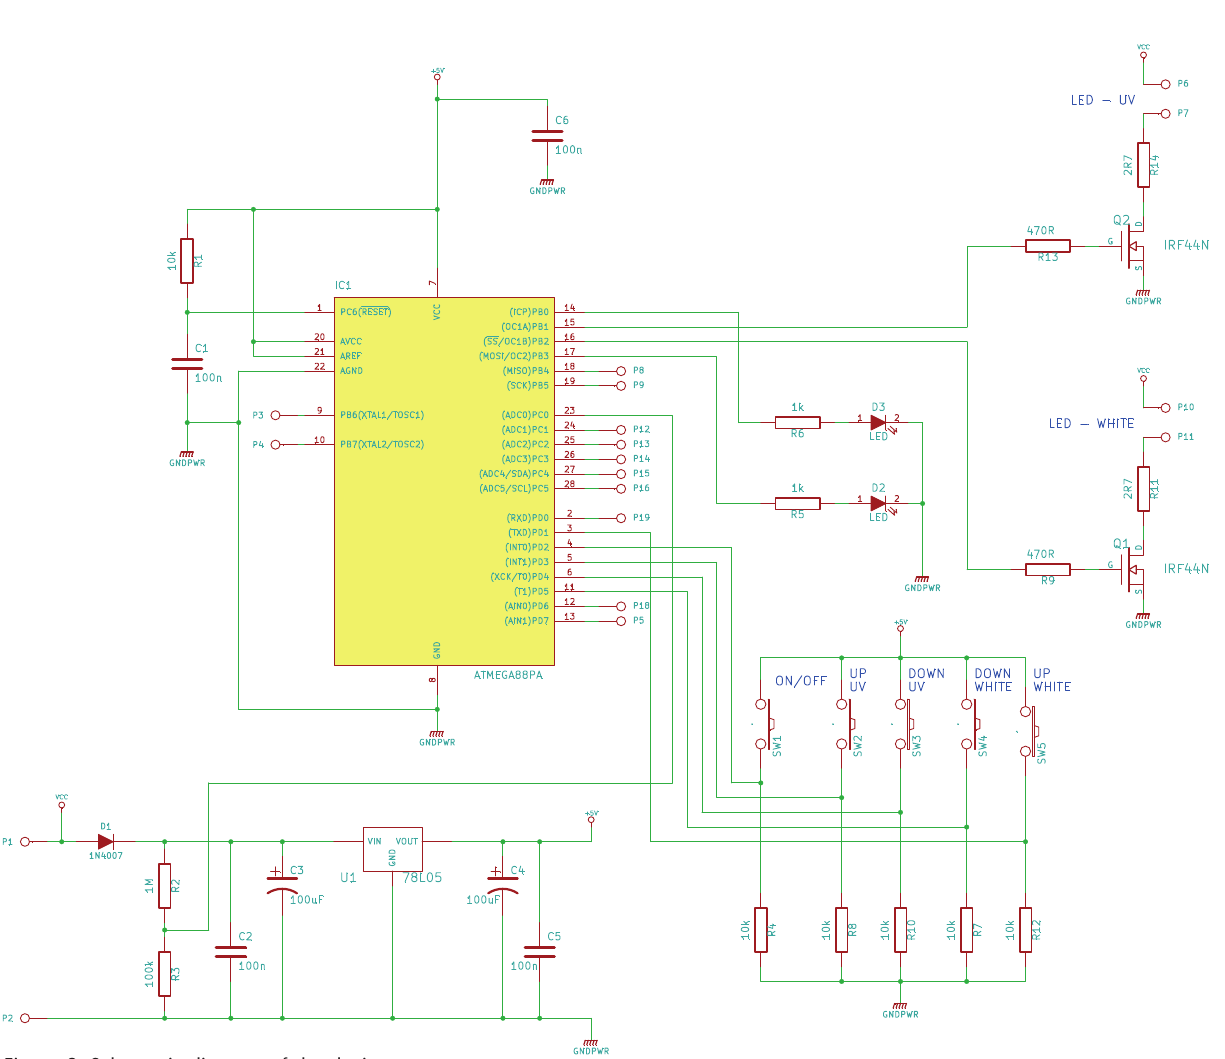
Figure 2. Schematic diagram of the